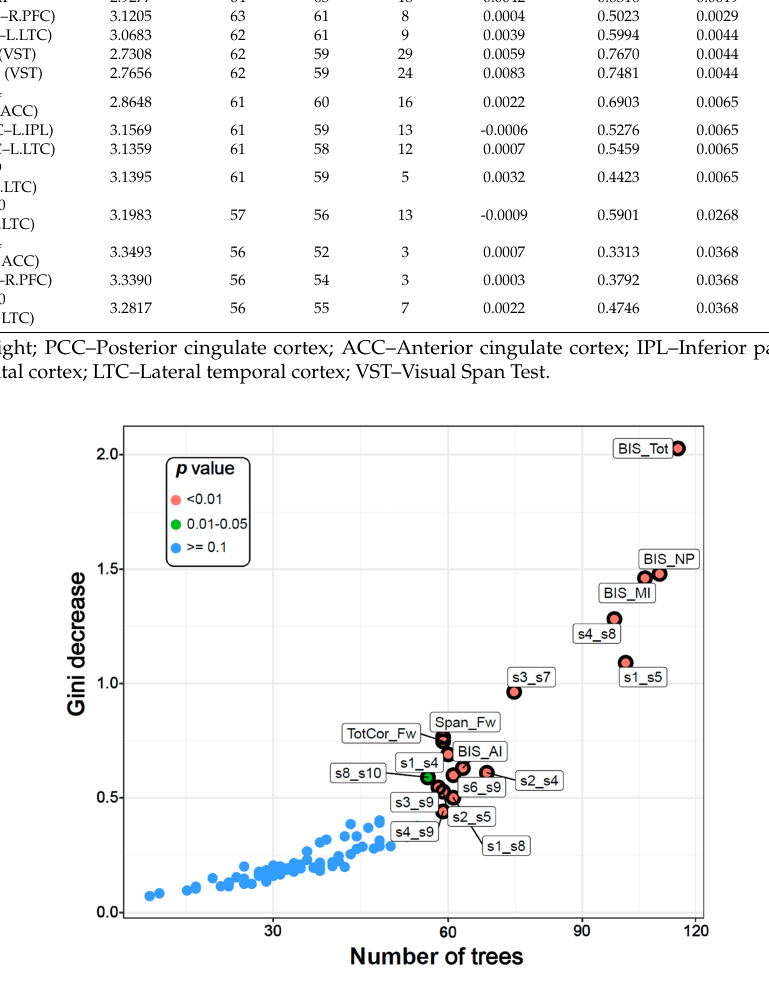
Figure 2. The multi-way importance plot showing the top significant variables (labelled and marked with black circles) that contributed to the classification of AUD from CTL individuals based on the following measures: the Gini decrease, the number of trees, and the p -values. Fourteen DMN connections, two neuropsychological variables, and all four impulsivity scores were significant (circled and labelled red and green dots). BIS–Barratt Impulsivity Scale; MI–Motor impulsivity; NP–Non-planning; AI–Attentional impulsivity; Tot–Total; Span_Fw–Span forward; TotCor_Fw–Total correct forward; s1-s12–DMN seeds 1-12 as listed in Table